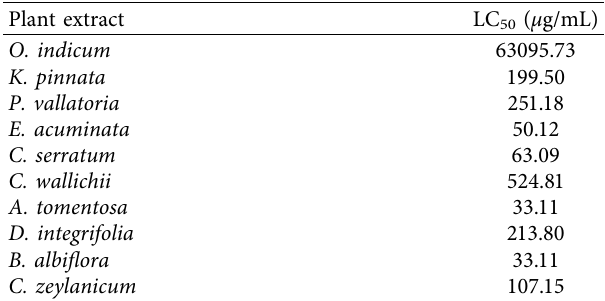
Table 6: LC 50 values of diferent plant